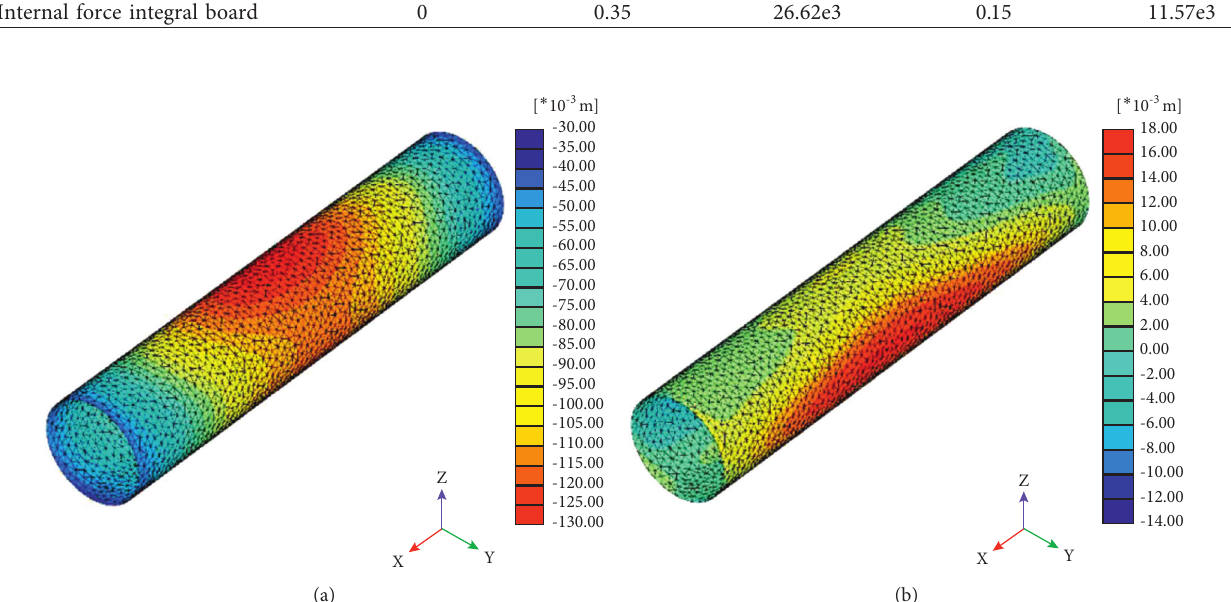
Figure 6: Displacement of tunnel segments. (a) Vertical displacement. (b) Lateral displacement.